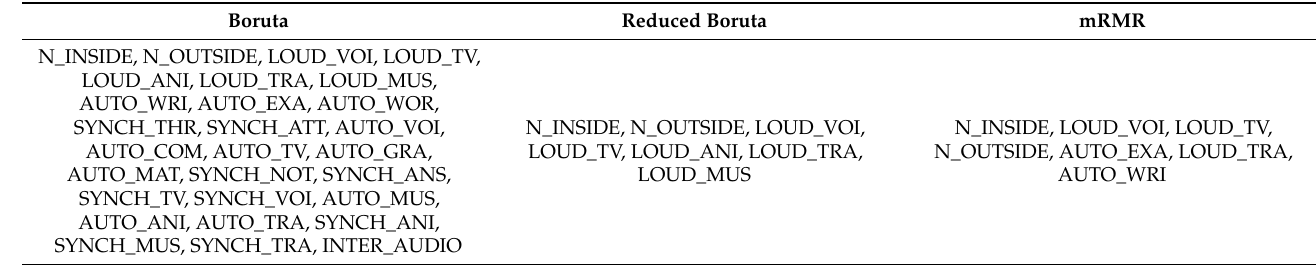
Table 4. Acronyms of the variables selected for the model of the noise interference with the au- tonomous activities using the Boruta (first column) and mRMR (third column) feature-selection methods listed by descending order of importance (using the Boruta relative importance and the mRMR scores, respectively). The second column shows a list with the same number of variables selected by the mRMR method, but it is composed of the first Boruta-selected variables. The meanings of the acronyms of the variables selected for the models are shown in Table A1.